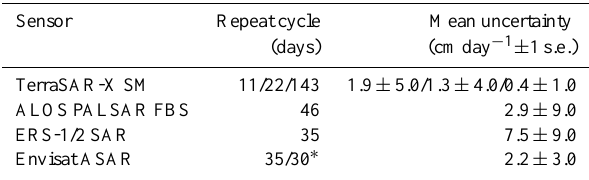
Table 2. Mean uncertainties of displacement fields calculated over nonmoving terrain given for each sensor and each temporal baseline (in cmday − 1 ± 1 standard error,